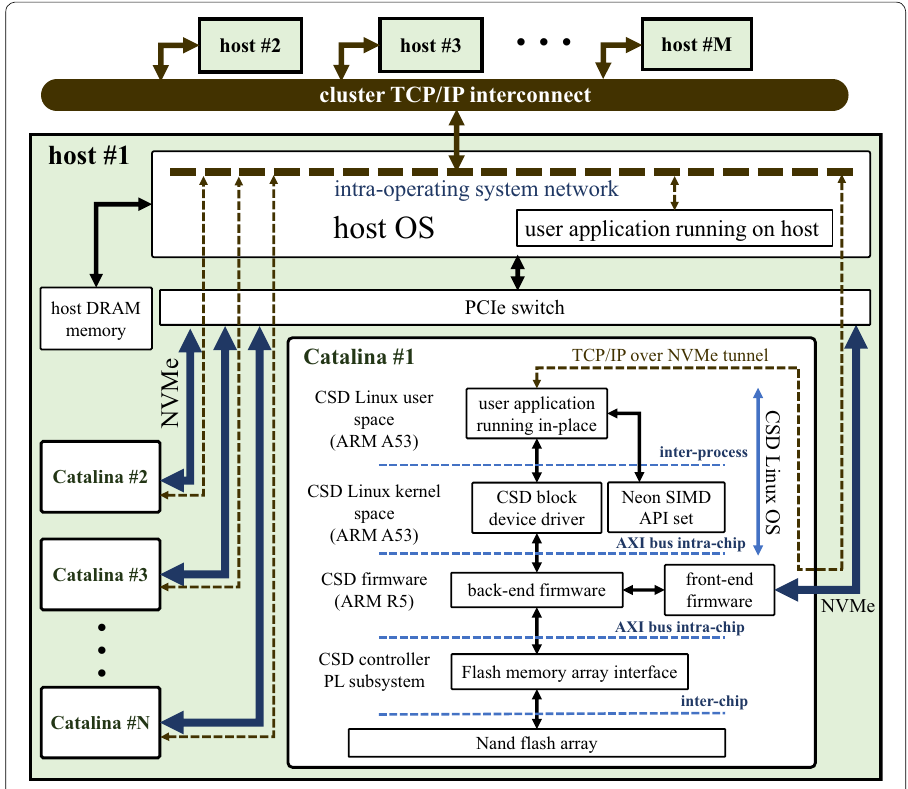
Fig. 5 Catalina CSD software